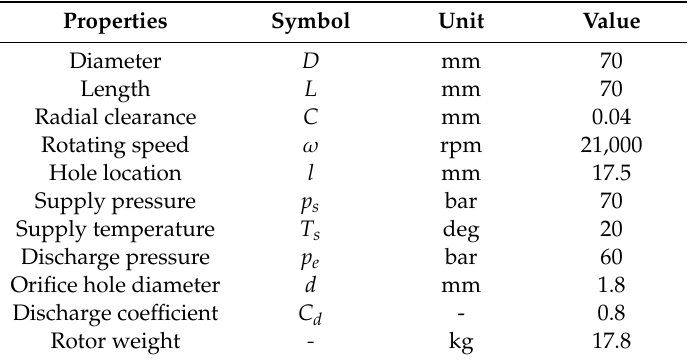
Figure 2. Illustration of hydrostatic radial bearing. Table 1. Design parameters for hydrostatic radial bearing and rotor.